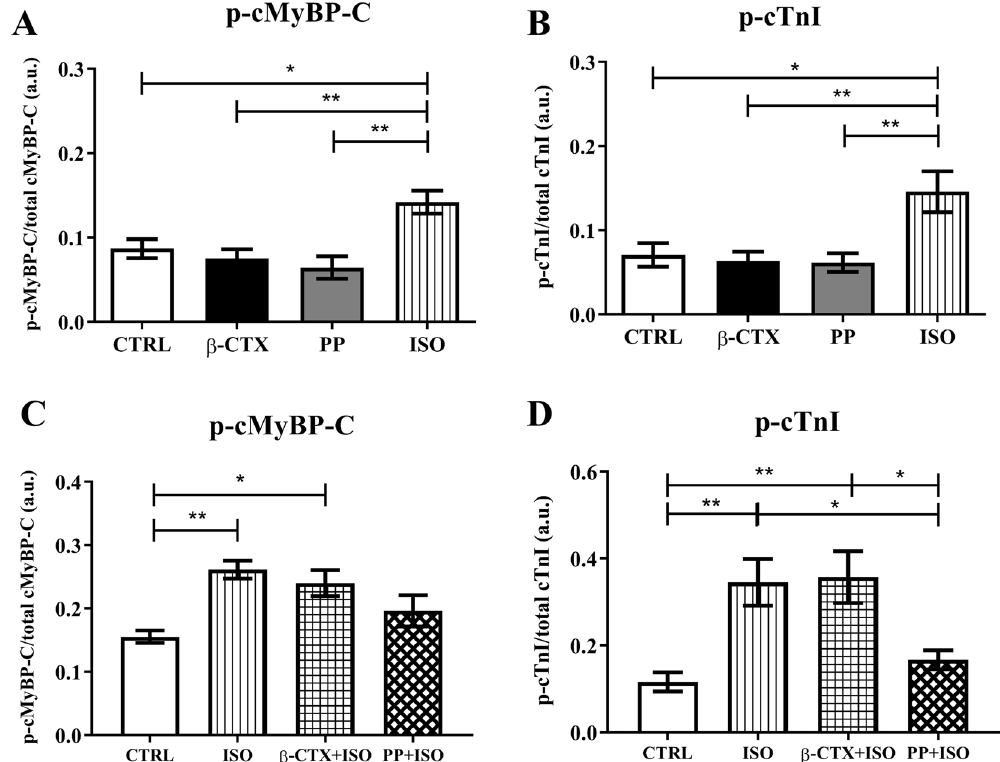
Figure 3. Results from phosphor-staining of cardiac myofilament comparing phosphorylation level of ( A ) cMyBP-C and ( B ) cTnI at the basal condition, and ( C ) cMyBP-C and ( D ) cTnI, in ISO-induced condition (n = 6 each). The full-length gels are provided in the supplemental file (Figure S2). Data are shown in mean ± S.E.M. Control (CTRL), Propranolol (PP), Isoproterenol (ISO), * p < 0.05, ** p <